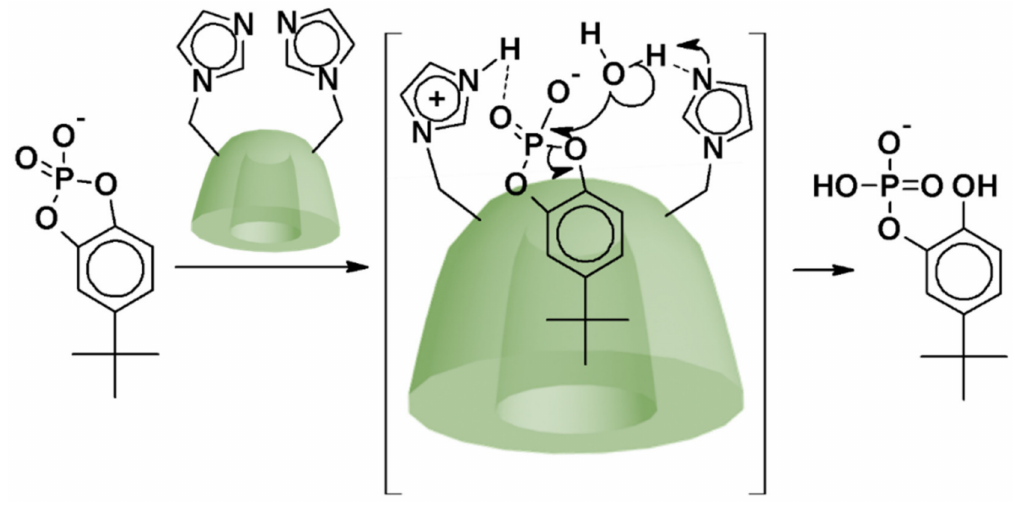
Figure 6. Bisimidazole-functionalized β -CD for the hydrolysis of a cyclic